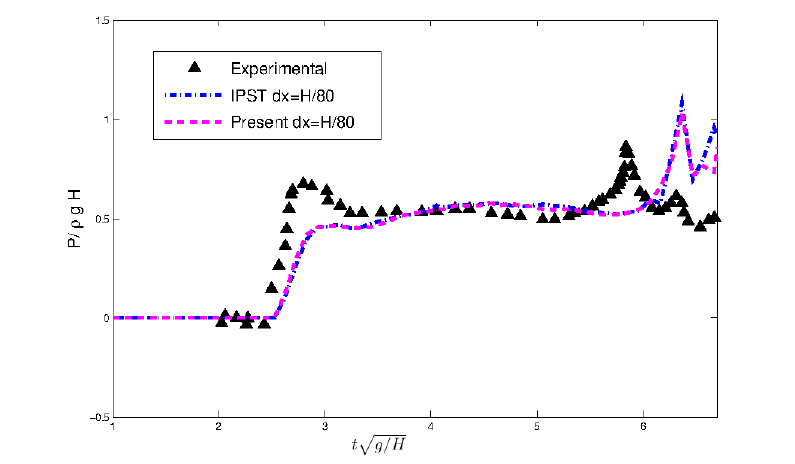
Figure 25. Dam break flow: History of the pressure signals recorded at P . The black triangles denotes the experimental data given by Buchner [69]. The blue dash-dot line represents the results obtained by using IPST [37], whereas for the magenta dashed line presents the results obtained by the present particle shifting